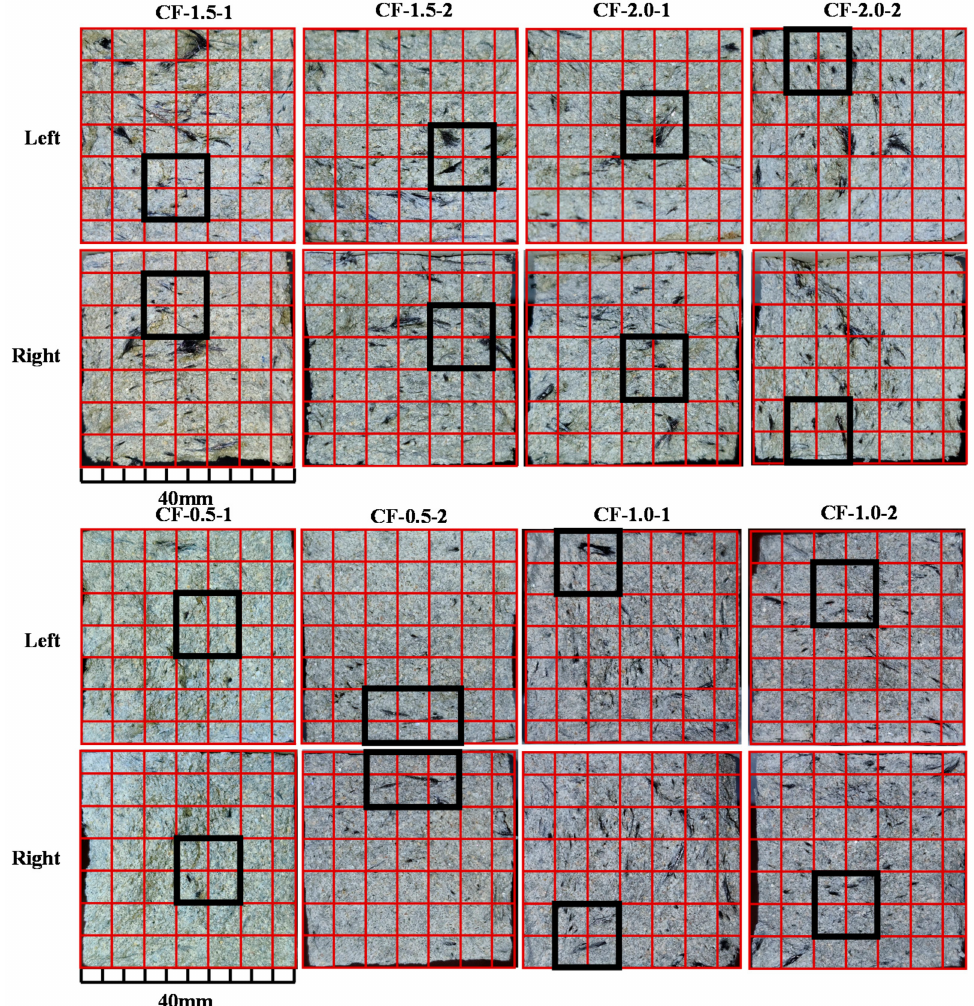
Figure 7. Cracked surfaces of prism samples of different fiber contents: the dark squares and rectangles represent sampled